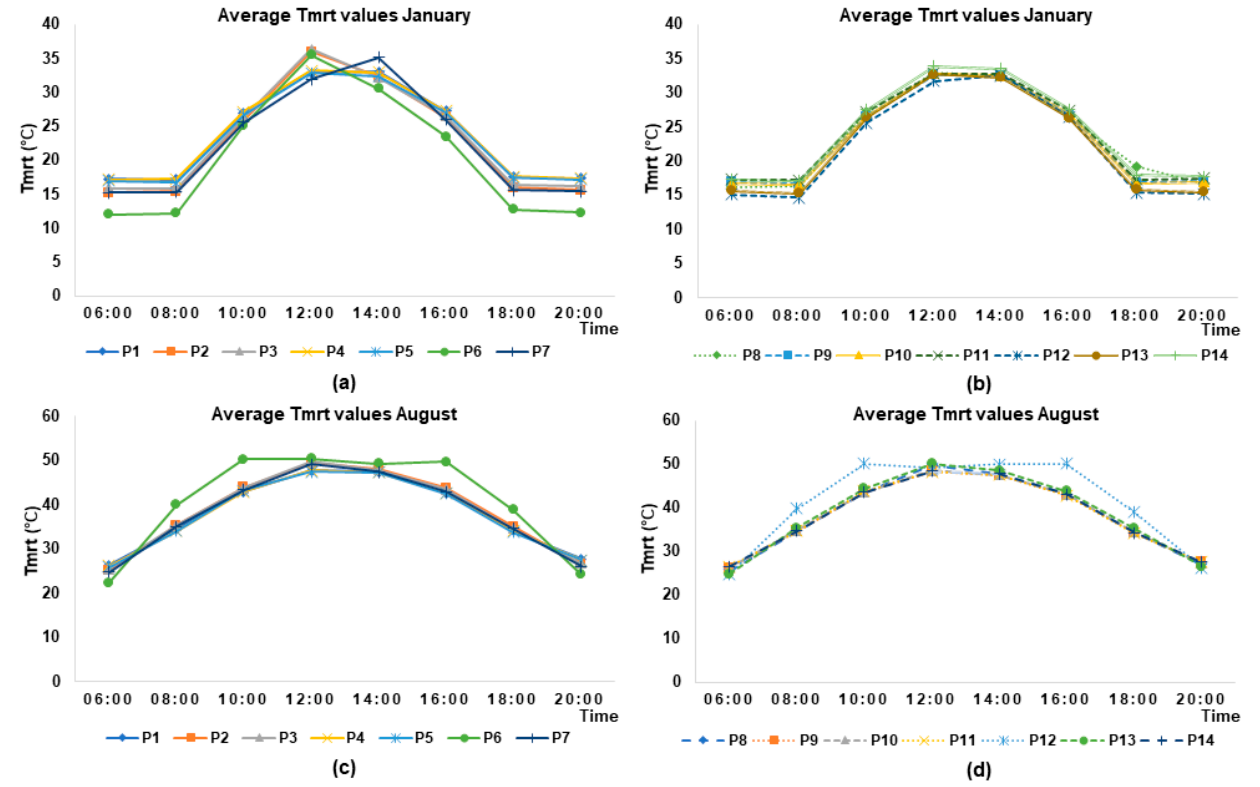
Figure 6. The average daily mean radiant temperature distribution at the 14 points studied in January ( a , b ) and August ( c , d ) 2021.